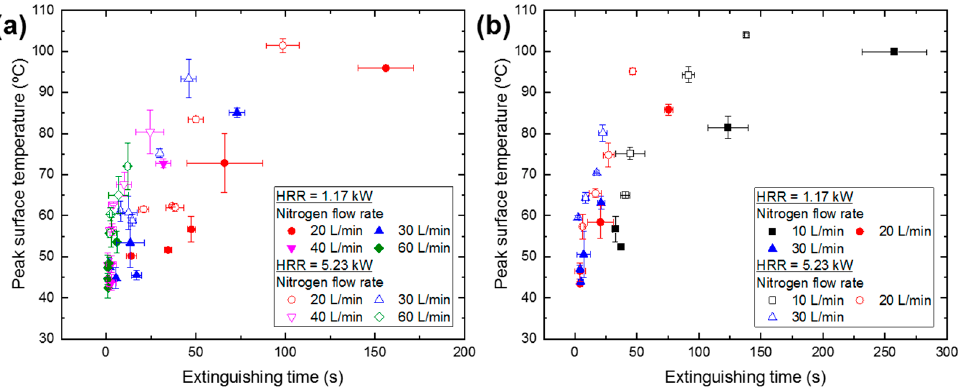
Figure 6. Extinguishing time vs. peak surface temperature for discharge area effect (note that the scales of x -axis in both figures are different): ( a ) large atomizer and ( b ) small